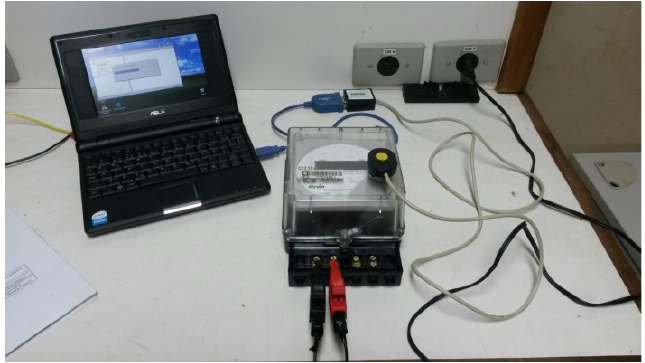
Fig. 2. Extraction of measurement